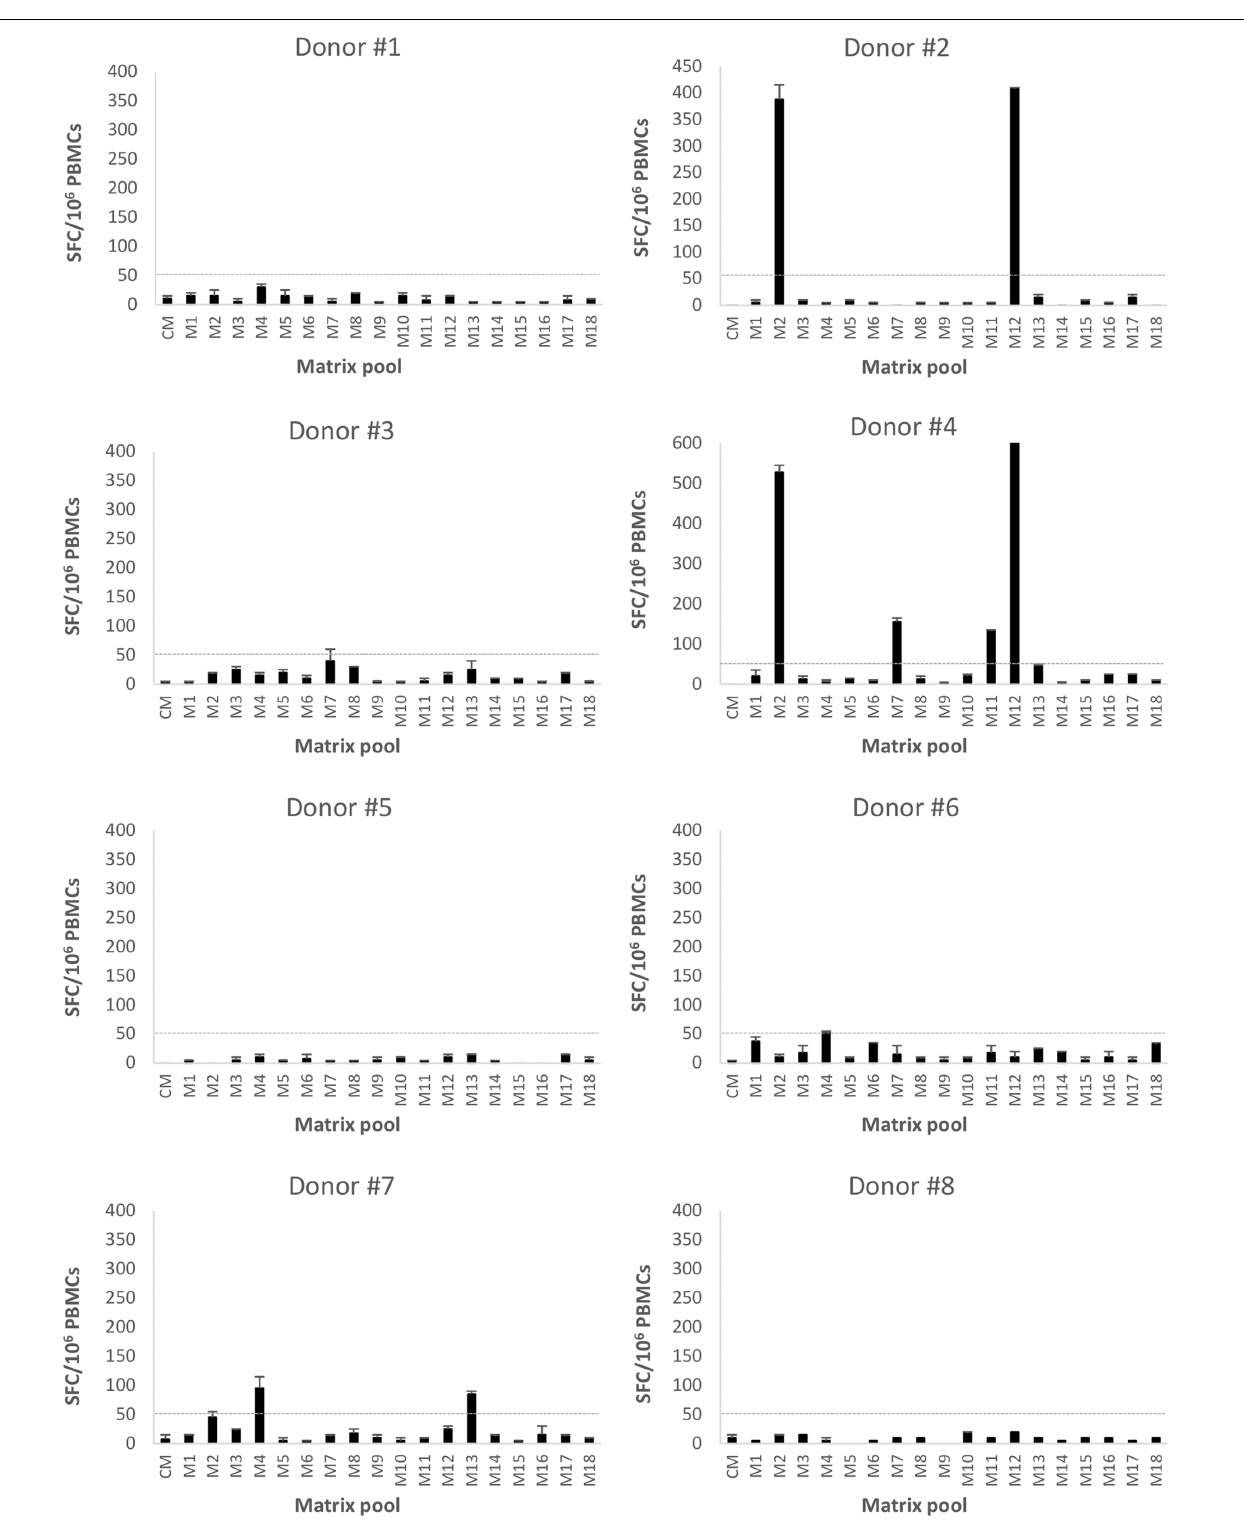
Frontiers in Microbiology |